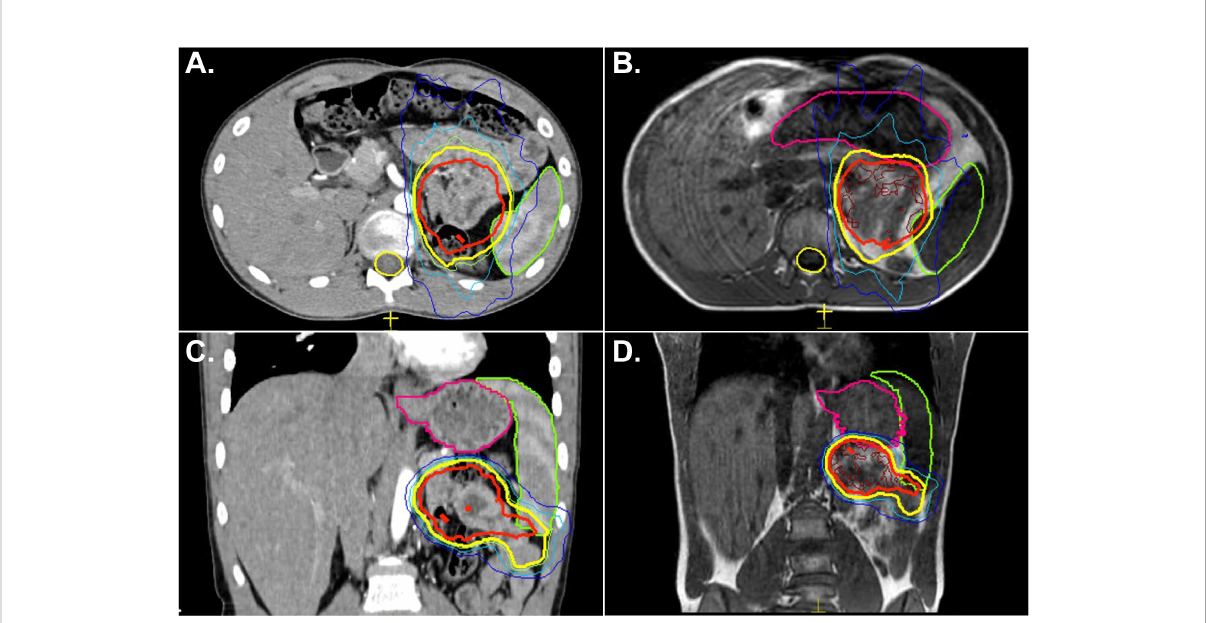
FIGURE 2 A 16-year-old male with history of kidney transplant and lymphoma presented with tarry stools and was found to have lymphoma recurrence in the jejunum as the only sites of disease. He received chemotherapy followed by radiation treatment to 45 Gy in 25 fractions. Panel (A) shows the radiation treatment plan on CT where the structure in green represents the spleen, the yellow line represents the 39 Gy isodose line, and the red line represents the 45 Gy isodose line. Panel (C) shows the initial treatment plan and the relationship to the stomach, outlined in pink. Panels (B, D) are a representative example of change in stomach shape while the patient underwent treatment. Without adapt-to-shape capability, the stomach would have received a higher dose than desired.